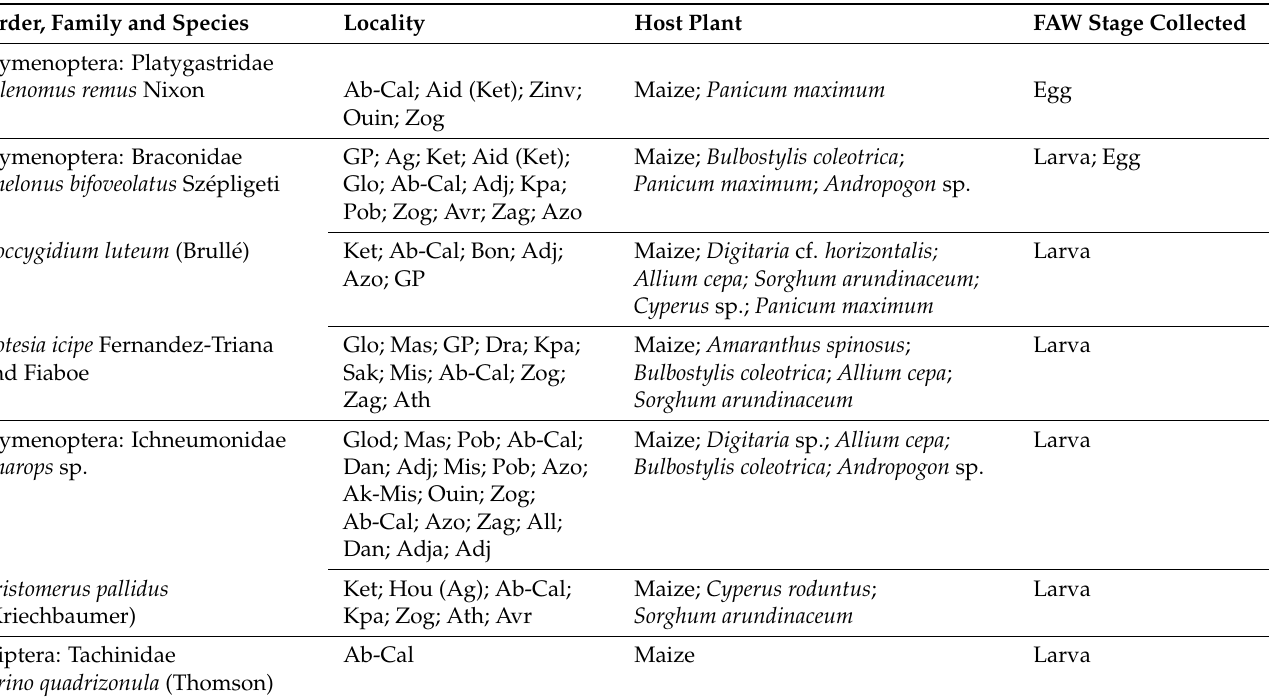
Table 2. FAW parasitoids complex associated with alternative host plants and maize in southern and central